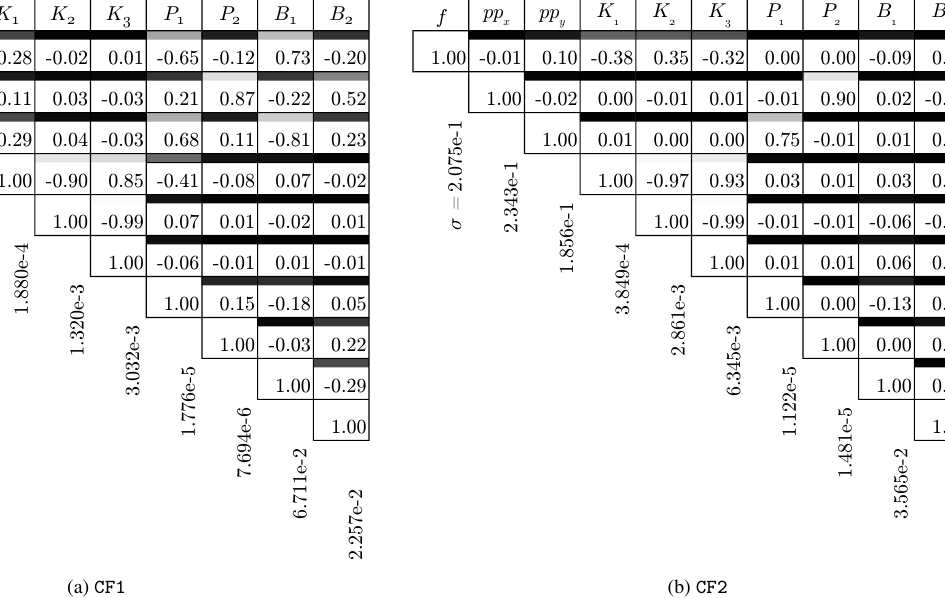
Figure 1. IO correlation matrix for Brown10 . Black to white colors highlight low and high correlation coefficients, respectively. where P i , f , pp x and pp y are taken from the output of the bundle adjustment for PF with OrthoPoly18 . A vector (cid:126)v M , i.e., the corrections implied by a given IO model, can be defined